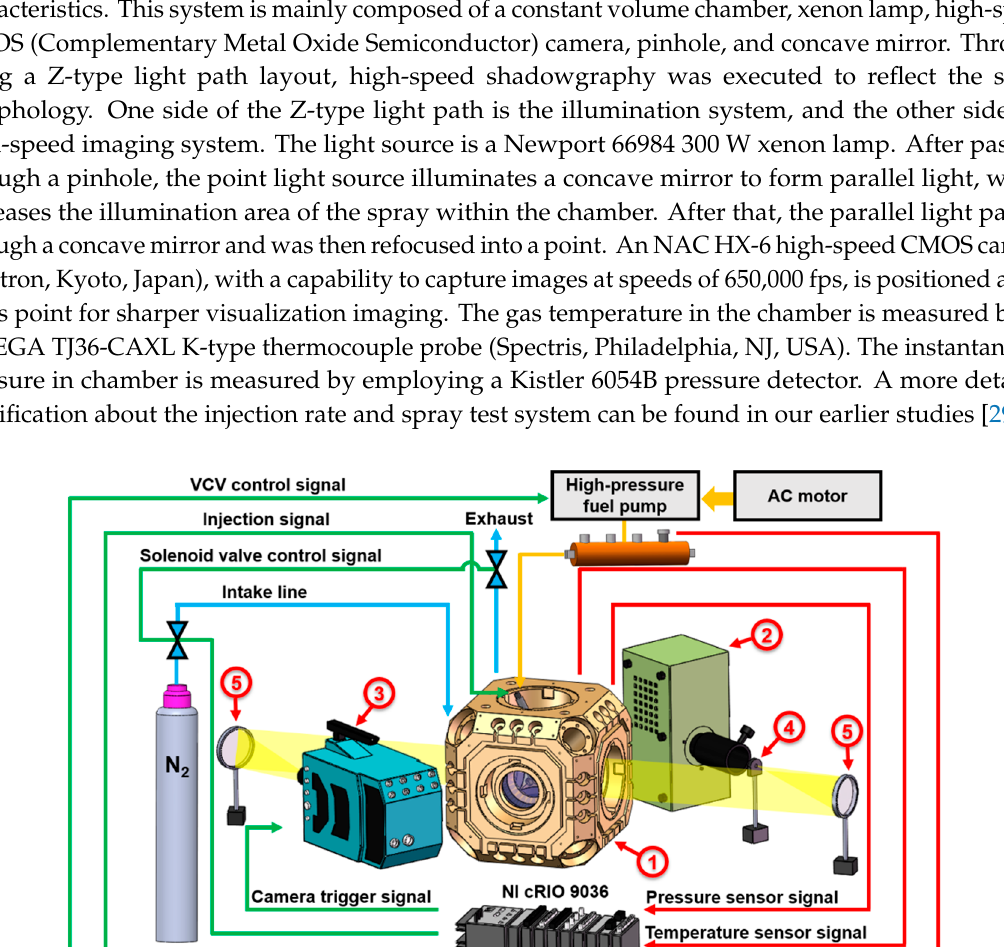
Figure 1. The designed test system for injection rate based on the long tube method.